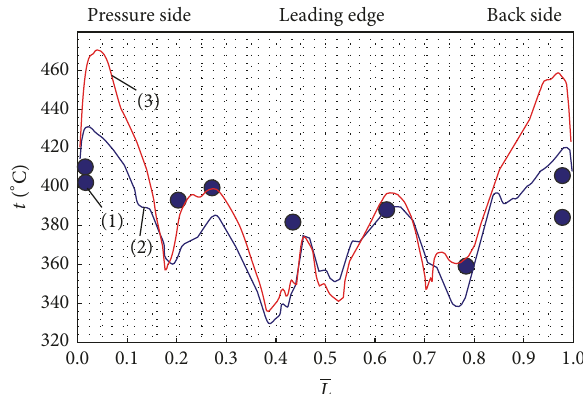
Figure 1: Temperature at the blade profile outline. (1) Experiment by Baranov Central Aircraft Engine Institute; (2) RKE model conjugated approach; (3) RKE model semiconjugated approach. selecting the most accurate calculating model. In particular areas, the discrepancy is up to 40 ∘ C while the gas temperature upstream the blade cascade is 614 ∘ C [12].